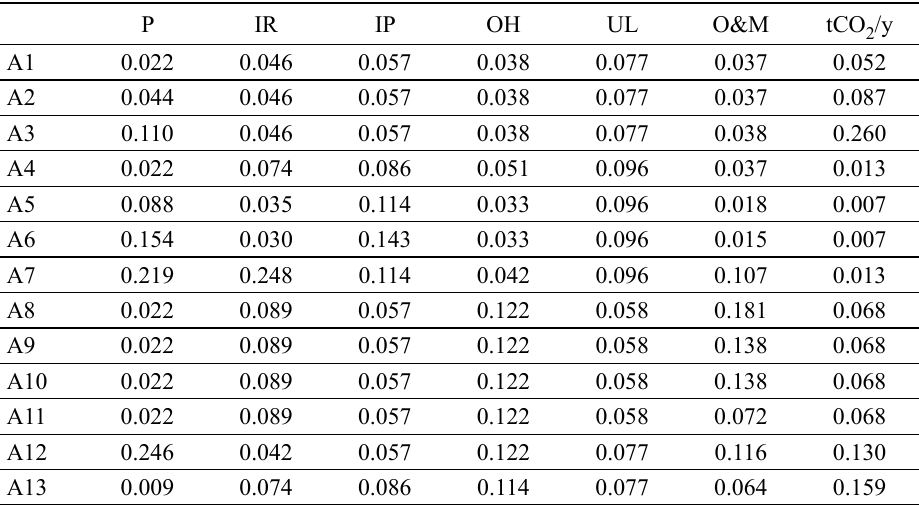
Table 7. Normalized decision